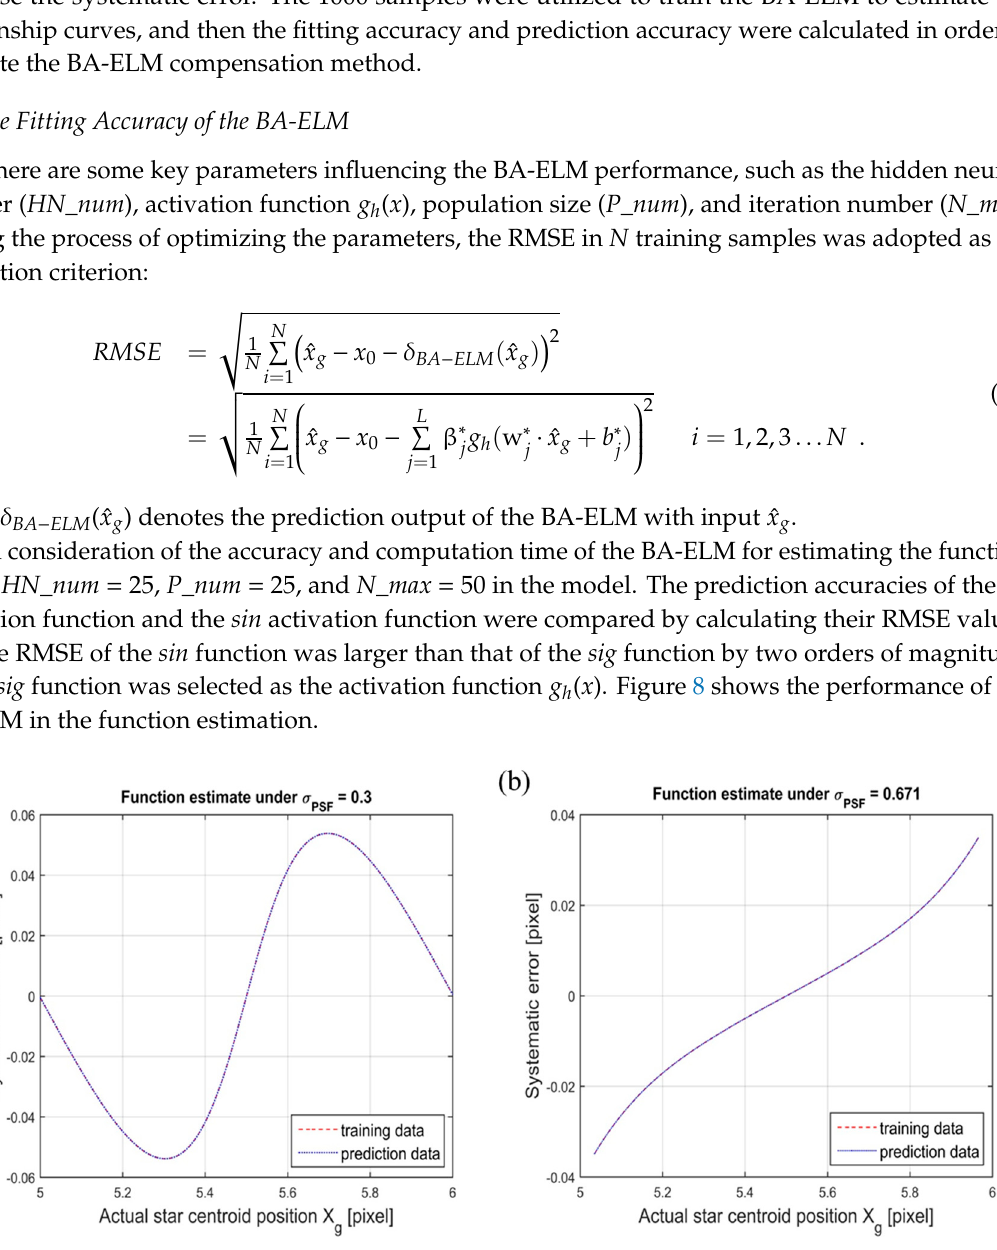
Figure 8. The fitting performance of the extreme learning machine optimized by the bat algorithm (BA-ELM). ( a ) Gaussian width σ PSF = 0.3. ( b ) Gaussian width σ PSF =